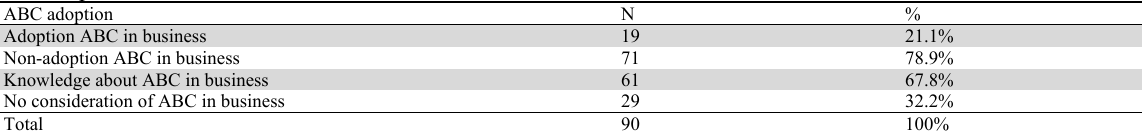
ABC adoption status in Vietnam ABC